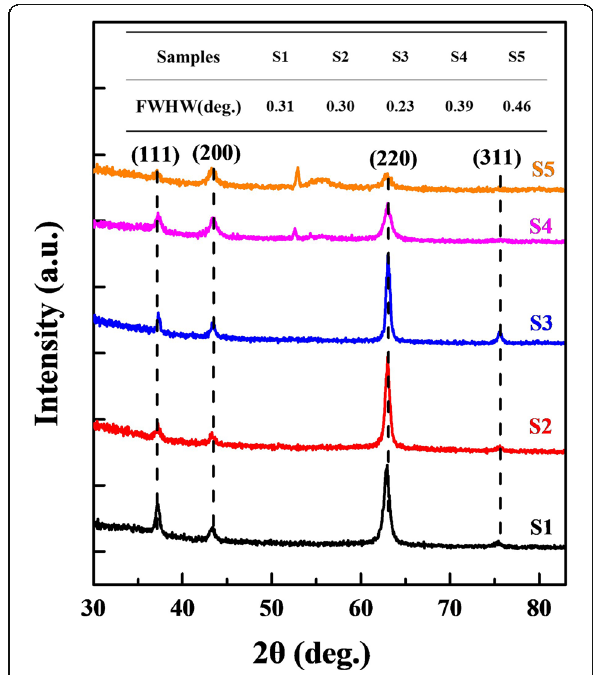
Fig. 2 XRD spectra of S1 – S5 samples. Insert table is the FWHW value of (220) for S1 –